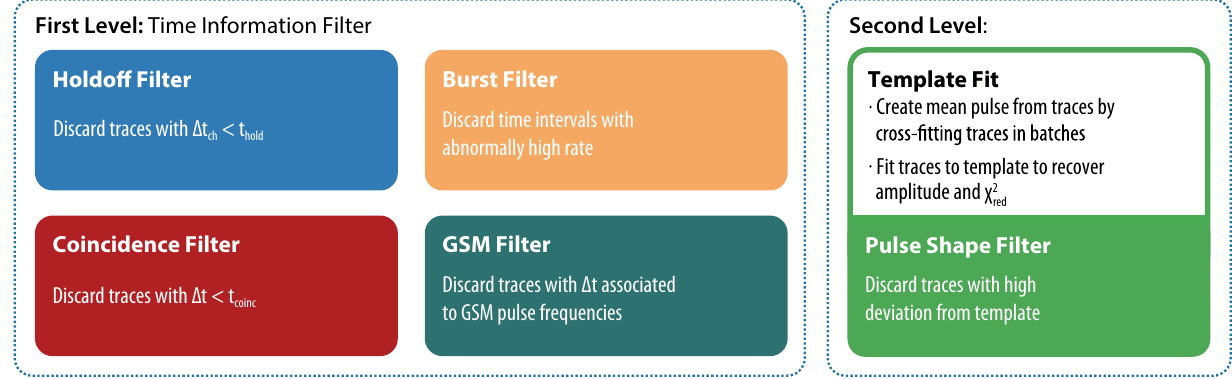
Fig. 4 Schematic of the two-level offline data reduction algorithm described in the